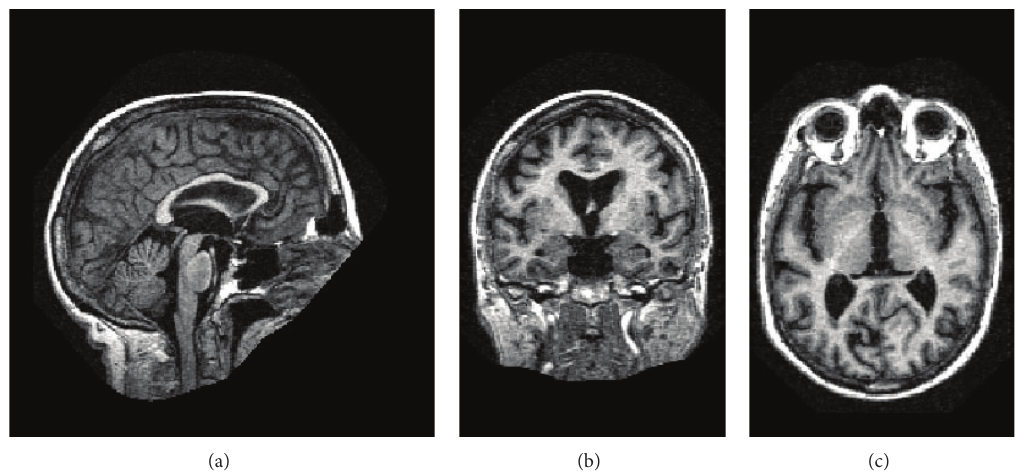
Figure 2: The three projections of the MR image in Figure 1: (a) sagittal, (b) coronal, and (c)